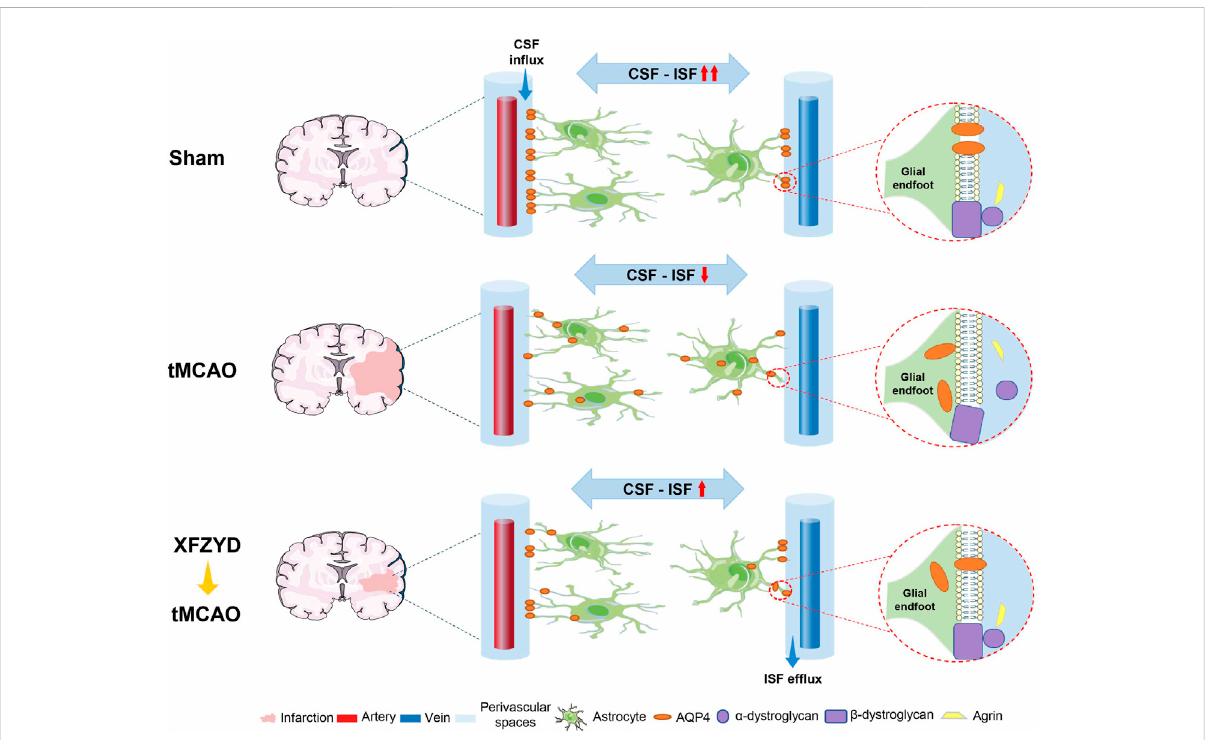
FIGURE 7 Schematic diagram of pharmacological mechanisms of XFZYD pretreatment for neurological de fi cits in tMCAO mice. XFZYD pretreatment increased colocalization of AQP4 with its anchoring proteins, α -dystroglycan, β -dystroglycan, and Agrin, to enhance AQP4 polarization on the glial endfoot and exchange ef fi ciency of CSF and ISF in the GS. Thus, XFZYD pretreatment can prevent the onset of neurodegeneration in